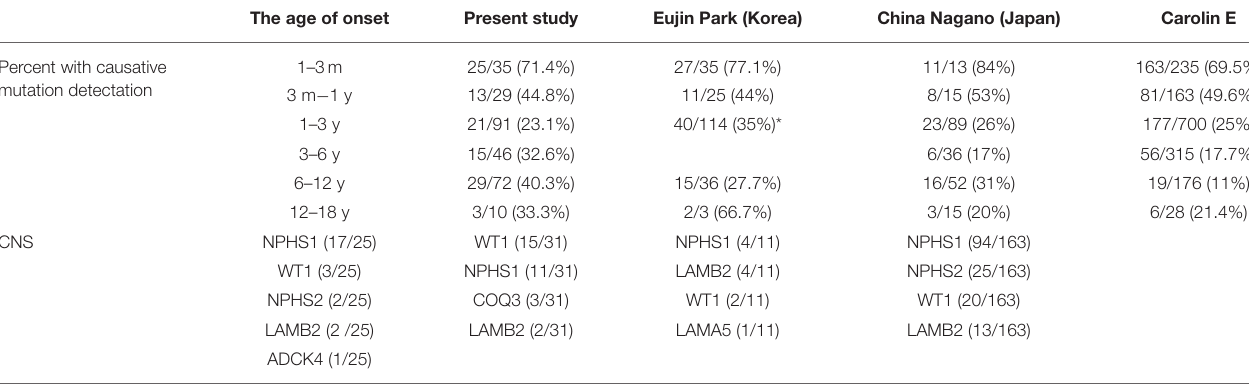
TABLE 2 | Age at onset, comparison with previous large studies. The age of onset Present